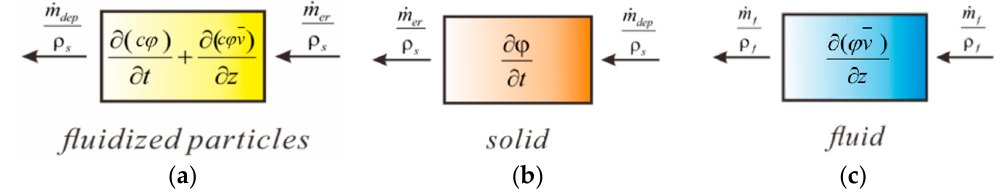
Figure 4. Mass conservation of the three phases: ( a ) Fluidized particles; ( b ) soil skeleton; ( c ) Pore fluid